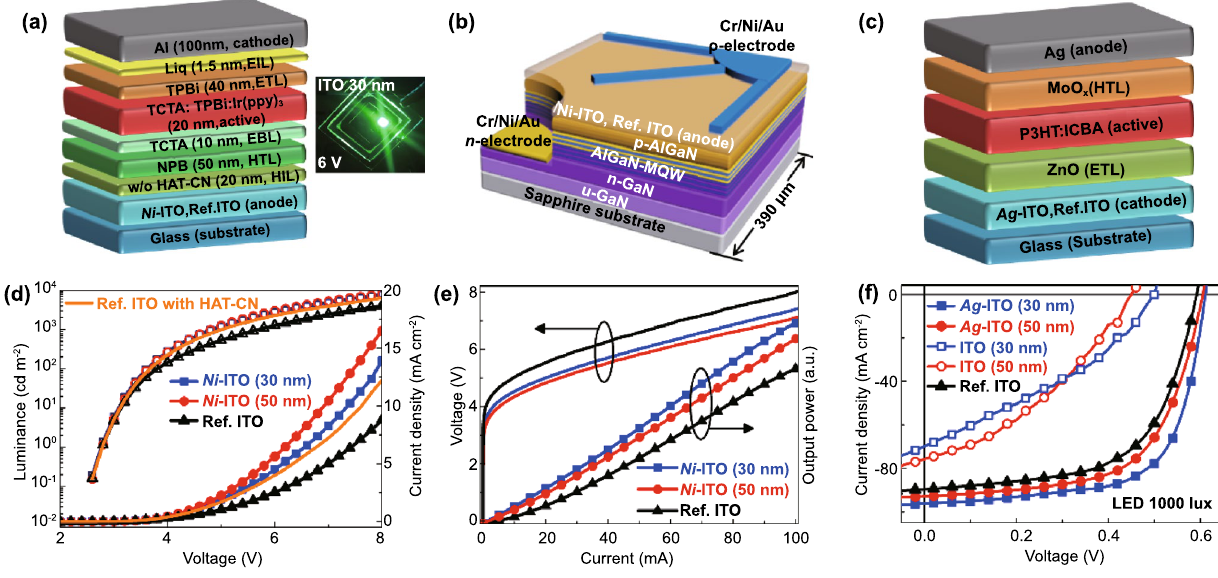
Fig. 5 Organic and inorganic devices using m ‑ITOs. Geometry (above) and current (density) versus voltage characteristics (below) of a, d OLED, b, e inorganic UV LED, and c, f